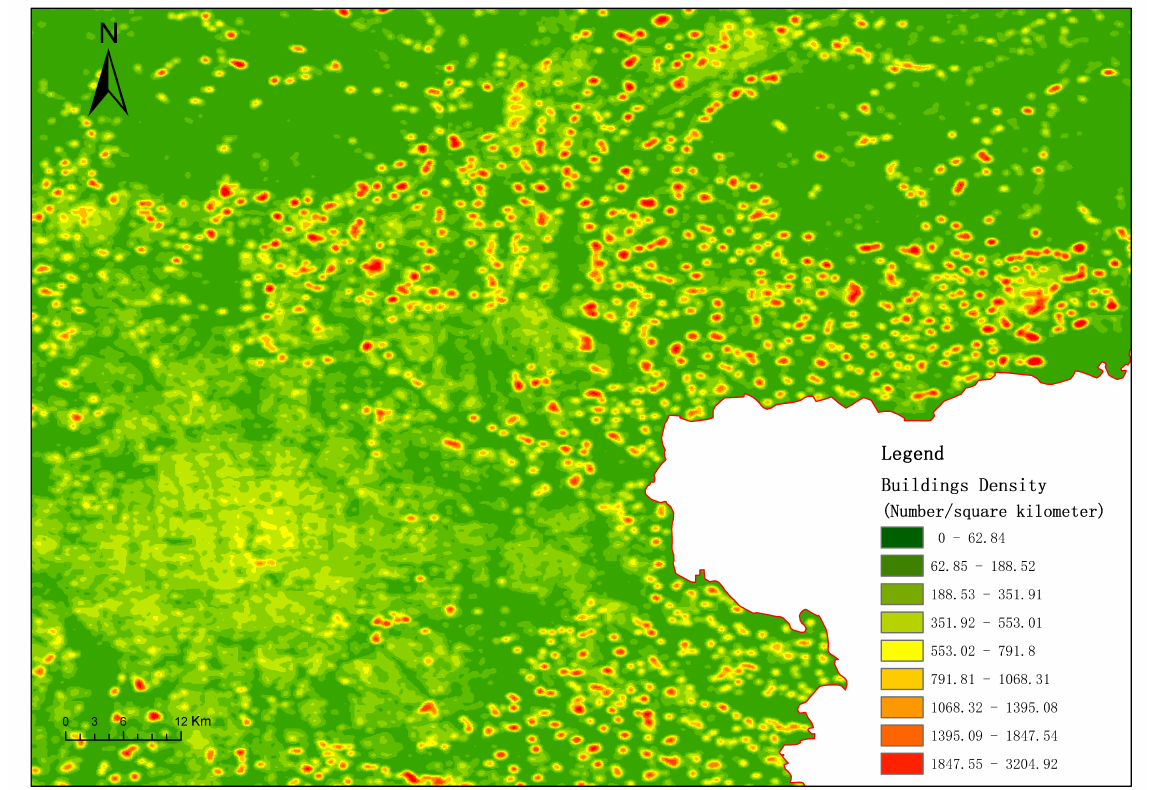
Figure 10. The results of the analysis of the core density of buildings in